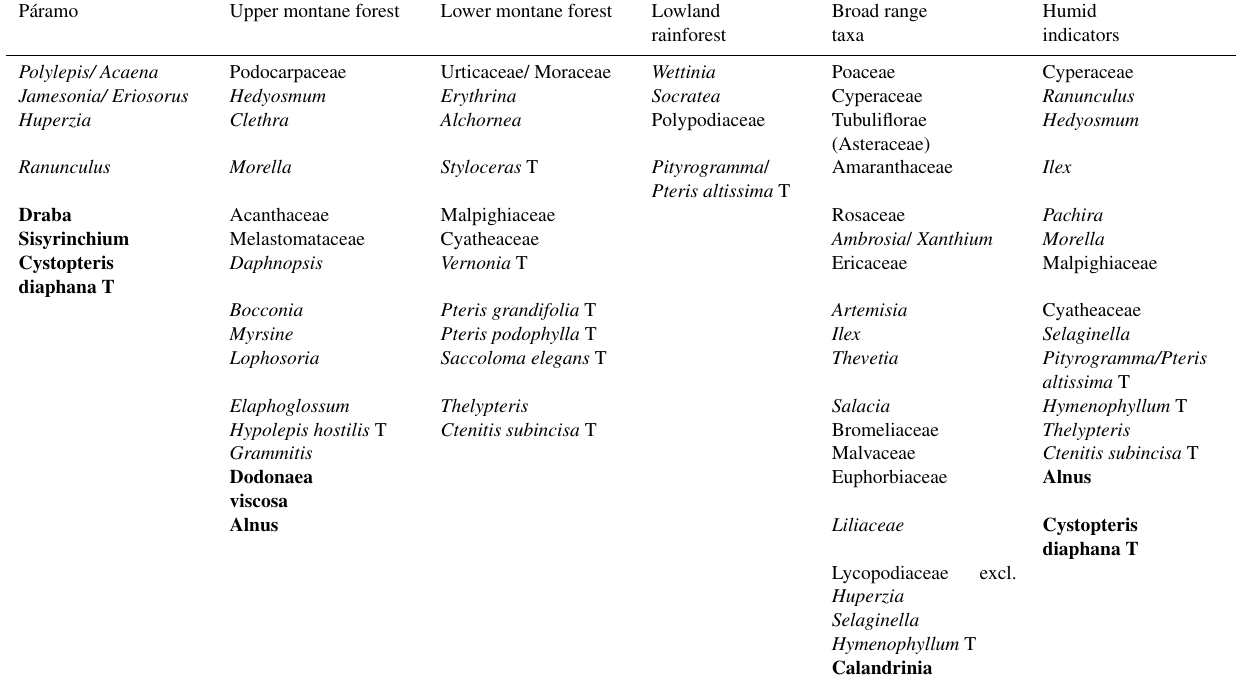
Table 1. List of identified pollen and spore taxa in marine ODP holes 1239A (Pliocene samples) and 1239B (core top samples; taxa in bold occurred only in core top samples) and grouping according to their main ecological affinity (Flantua et al., 2014; Marchant et al., 2002).